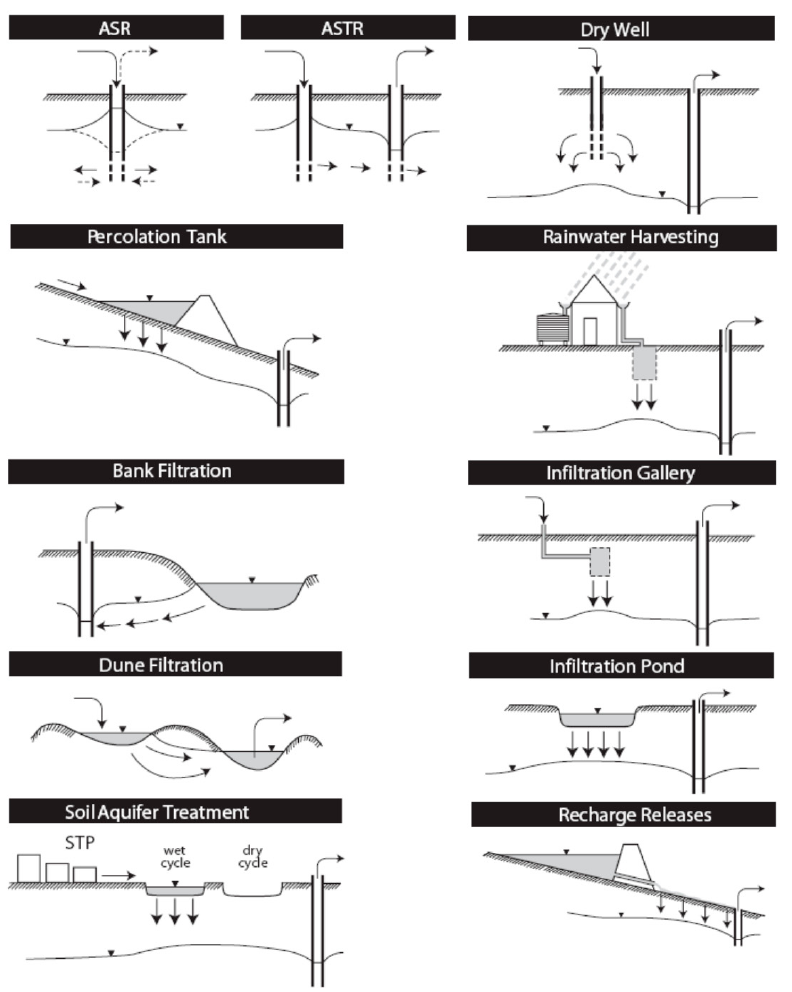
Figure 1. Schematic of types of MAR suited to urban water management (modified from: Dillon, 2005 [2]). ASR—Aquifer Storage and Recovery; ASTR—Aquifer Storage Transfer Recovery; STP—Sewerage Treatment Plant.